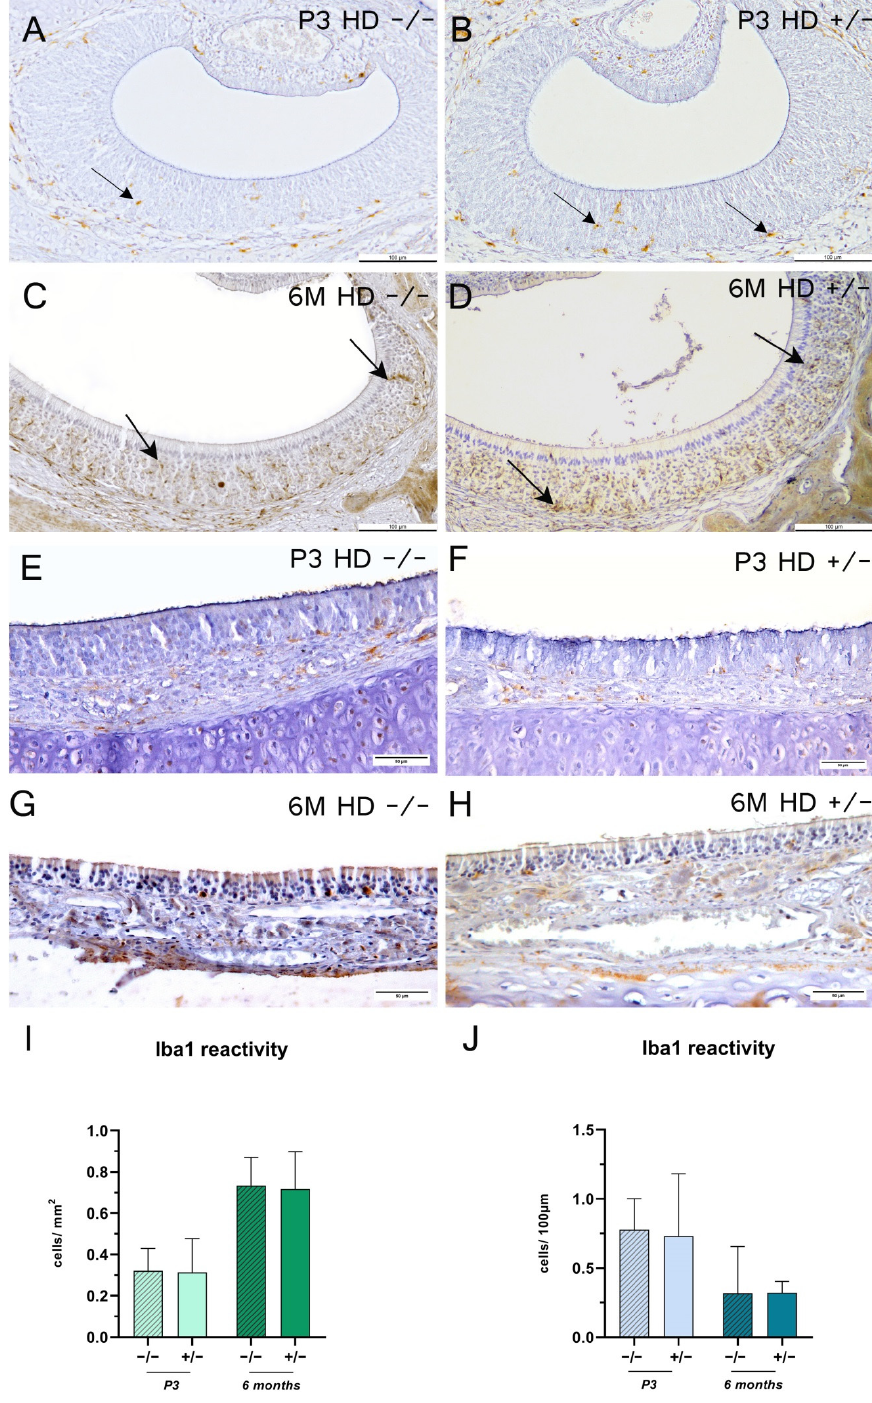
Figure 6. Ionized calcium binding adapter molecule 1 (Iba1) reaction for 3-days-old (P3) and 6-month- old (6 M) rats. ( A – H ) Representative immunohistochemical reaction of Iba1- in the vomeronasal epithelium ( A – D ) and main olfactory epithelium ( E – H ). Arrows indicate Iba1-positive cells. Scale bars: ( A , B ) 100 µ m; ( C , D ) 20 µ m; ( E – H ) 50 µ m. Column bars show Iba1-reactive cell counts per mm 2 ( I ) or per 100 µ m ( J ); n = 6; ( J ) +/ − 6 M: n = 5. The significance of differences between groups was tested with mixed-effects analysis followed by Bonferroni’s multiple comparisons (age x genotype interaction: ( I ) F value = 0.01017, degree of freedom = 1; ( J ) F value = 0.03404, degree of freedom = 1). Data are presented as means ± SD and statistical significance was set at p <